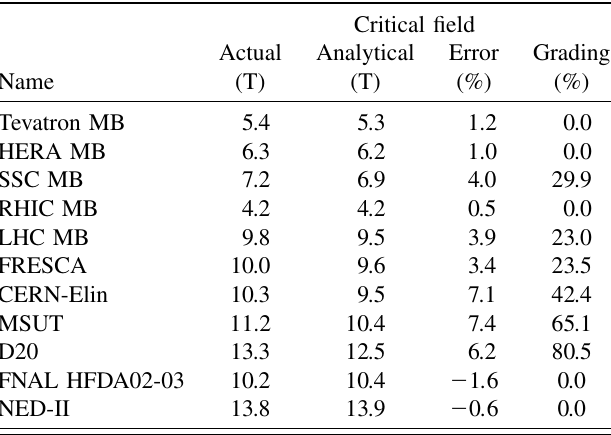
TABLE VII. Actual and analytical estimates of critical field for 11 superconducting dipoles (no iron).